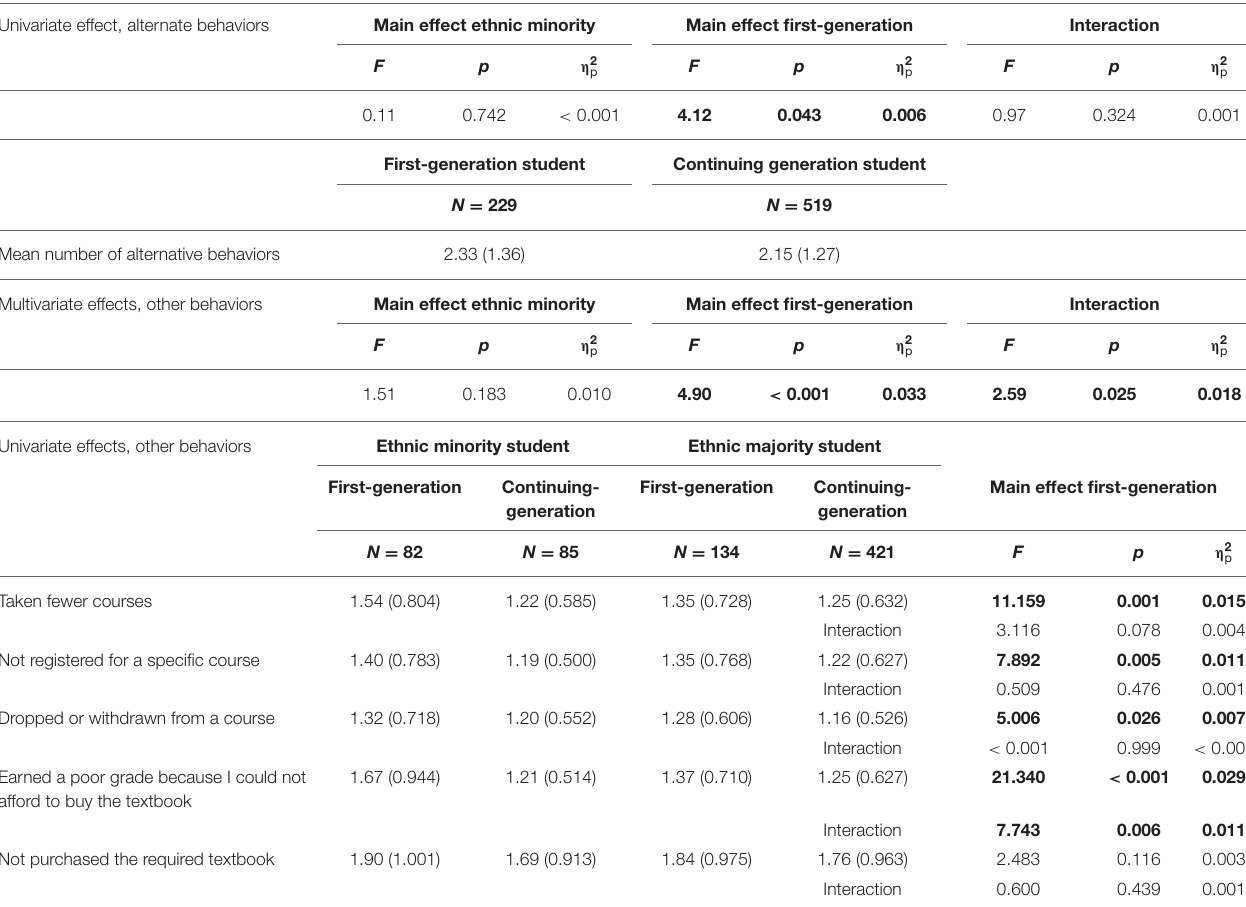
TABLE 2 | Student behaviors by demographic groups.